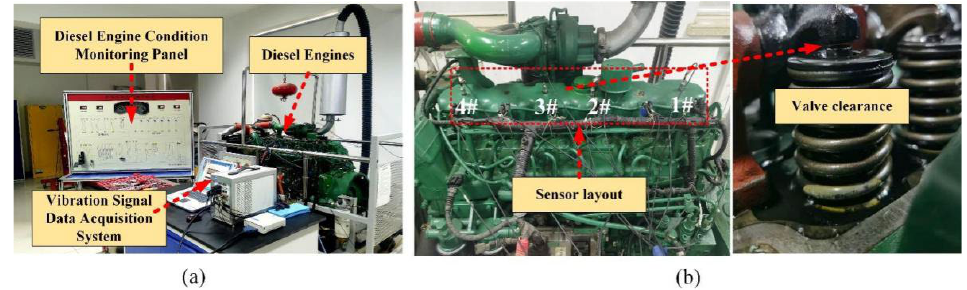
Figure 2. Diesel engine preset failure experiment environment: ( a ) test bench; ( b ) intake valve clearance failure. Table 1. Experimental Dataset of Valve Clearance in Different Working Conditions.